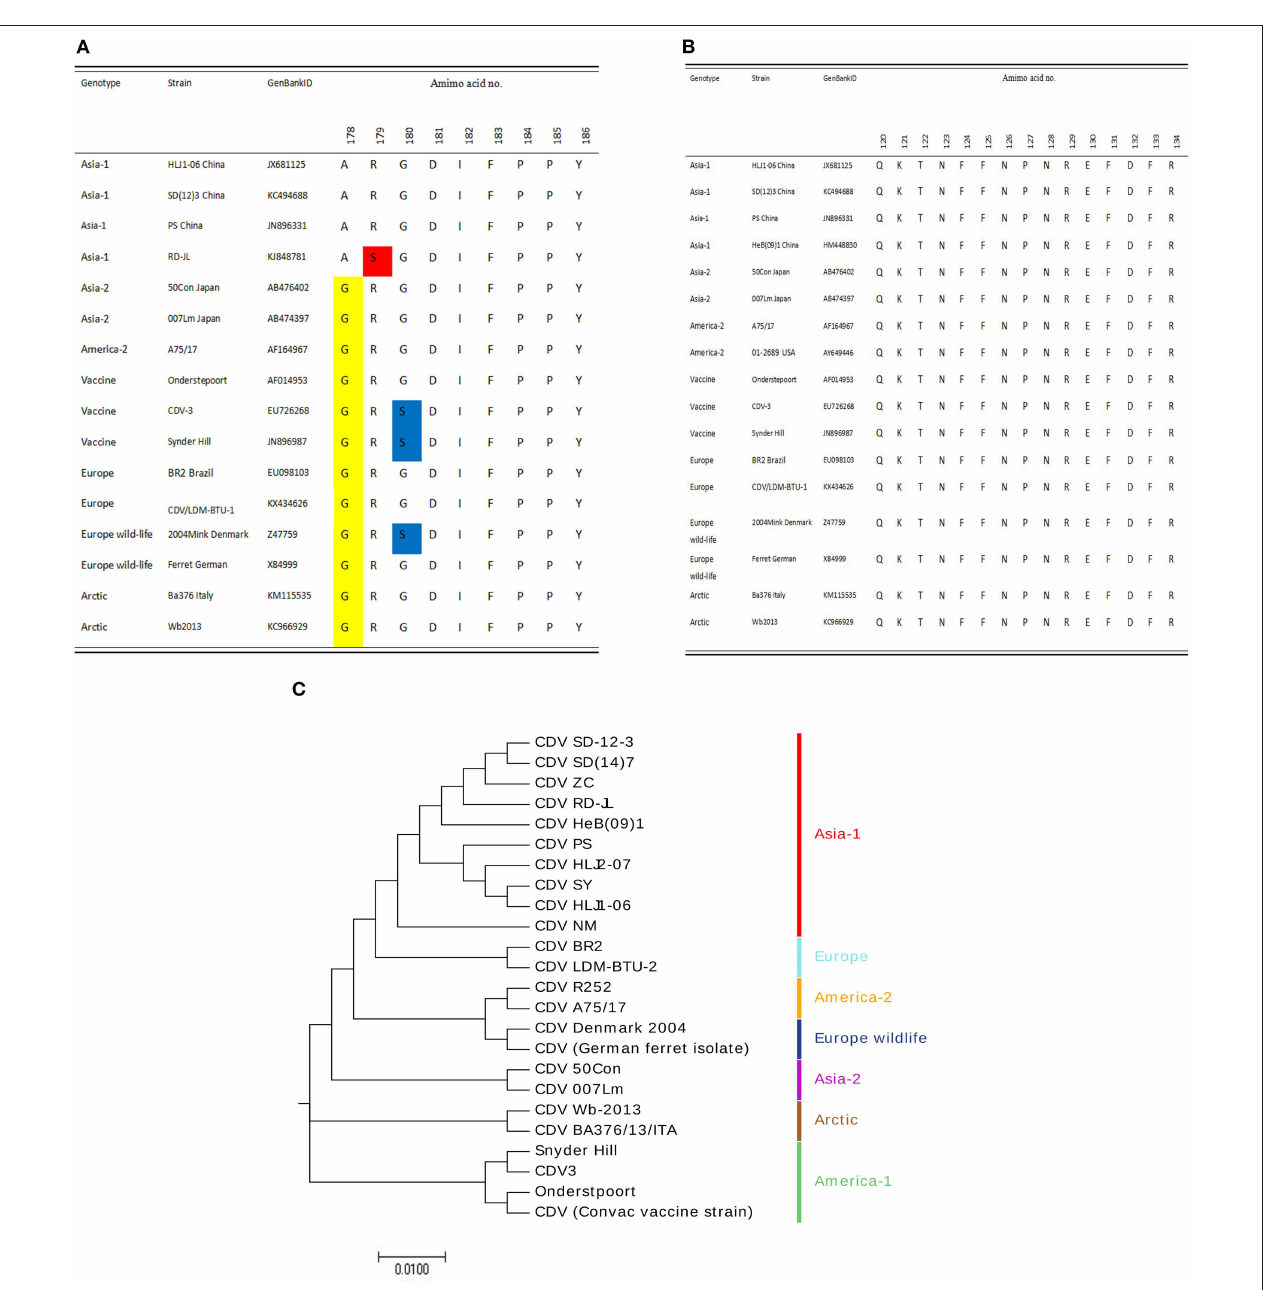
FIGURE 3 | Conservation analysis of the epitopes. (A) Conservation analysis of the epitope F14-1 among different CDV strains. The yellow highlight indicates the difference on 178 amino acid identity, the red highlight shows the difference on 179 amino acid identity, and the mutation on 180 amino acids with blue highlight. (B) Conservation analysis of the epitope F8 among different CDV strains. (C) Genotyping of 24 CDV strains based on H protein sequences. The phylogenetic tree was constructed using the neighbor-joining method in MEGA 7.0 with bootstrap values from 1,000 resamplings shown for each node. GenBank accession numbers of all isolates used are listed in Table S1